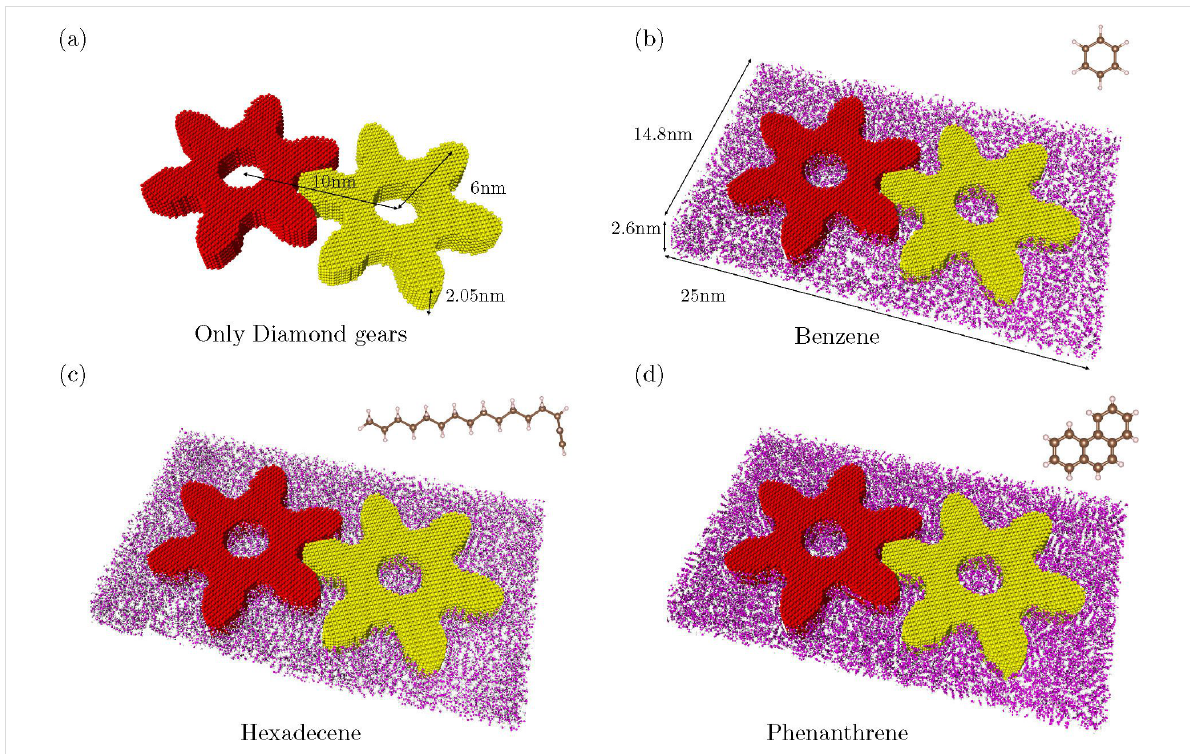
Figure 1: A schematic illustration of two interlocked diamond involute solid-state gears (red and yellow) with separation distance 10 nm, tip radius 6 nm and thickness 2.05 nm; (a) without lubricants and lubricated by (b) benzene, (c) hexadecene and (d) phenanthrene molecules where the purple and white atoms denote the carbon and hydrogen atoms of the lubricant, respectively. The dimension of the lubricant layer shown here is 25 × 14.8 × 2.6 nm 3 for better visibility, but note that the actual thickness of the lubricant layer is 5.0–5.5 nm to ensure that the gears are fully immersed.